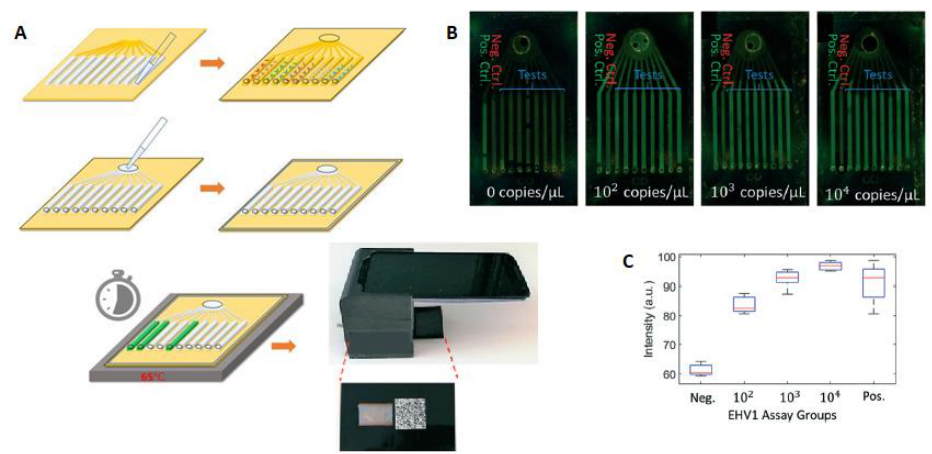
Figure 5. The workflow of the LAMP-based on-chip detection, ( A ) Deposition of the primers and controls, injection of LAMP reaction mix, heating the chip at 65 °C and insertion into the cradle for end-point fluorescence imaging for 30 min. ( B ) different concentrations of EHV1 templates were amplified on the chips (from left to right, channel 1: positive control, channel 2: negative control and channel 3–10: EHV1 primers). ( C ) the average intensity reported for the channels for each assay [199].